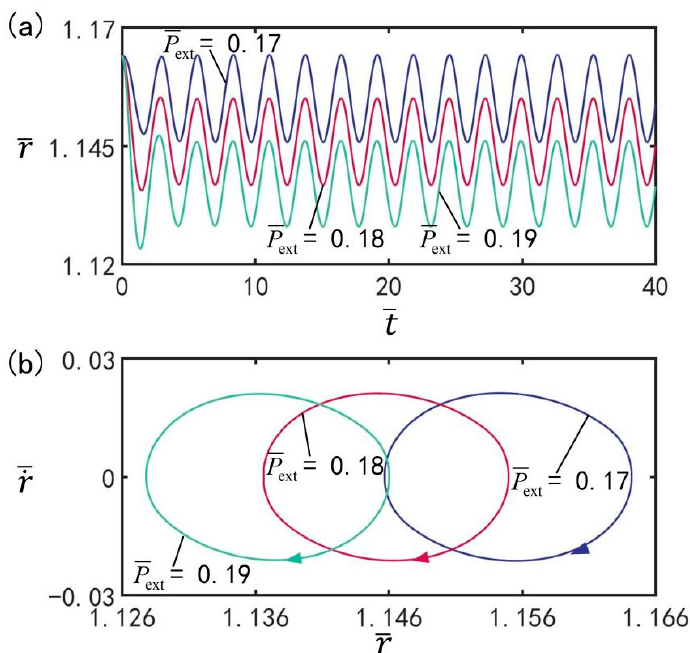
Figure 11. The influence of external pressure p on the beating of LCE balloon. ( a ) Time histories; 0 ( b ) Limit cycles. The parameters are T on / T L = 0.5, T L = 2.7, I = 0.5, C 0 = 0.3, n I = 0.45 ( r I = 1.164 ) , . V L = 0.05, ρ = 0.16, β = 0.14, and r I = 0. With increasing external pressure, the beating amplitude decreases.